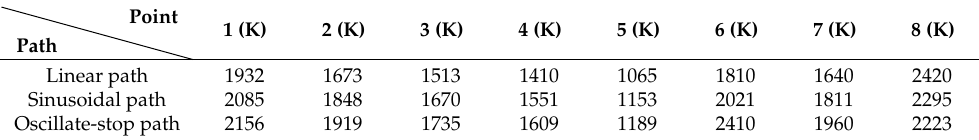
Table 8. The peak temperature of selected point as shown in Figure 8.